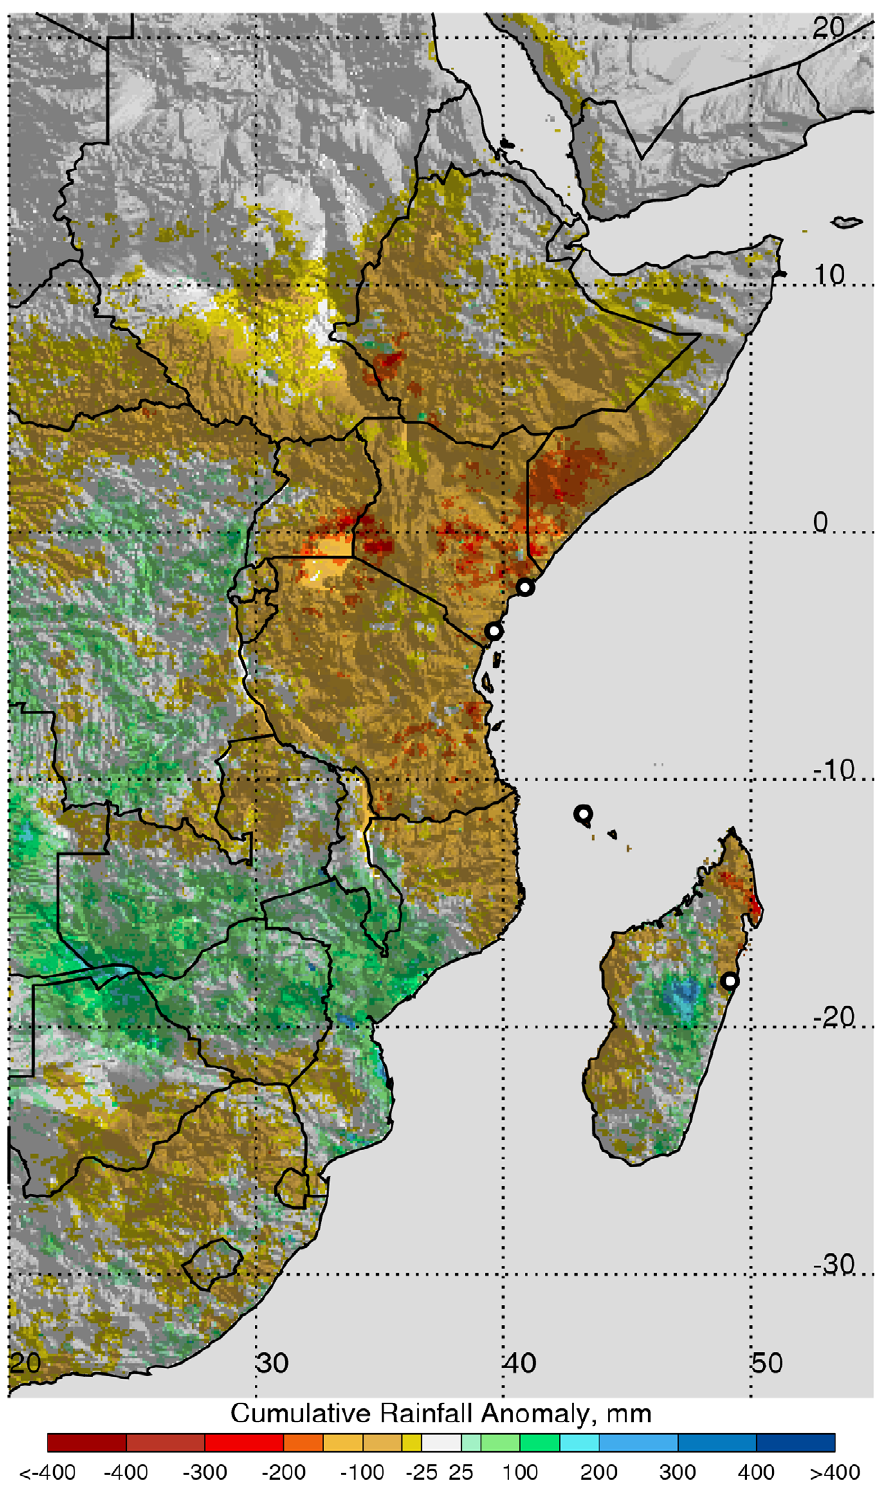
Figure 3. Cumulative rainfall anomalies over Eastern Africa, October–December, 2005. Negative rainfall anomalies correspond to the large-scale regional drought in Eastern Africa during October–December, 2005. Anomalies were calculated with reference to the 1995–2000 long term mean. Epicenters of chikungunya outbreaks during this period are shown by the four open black dots.